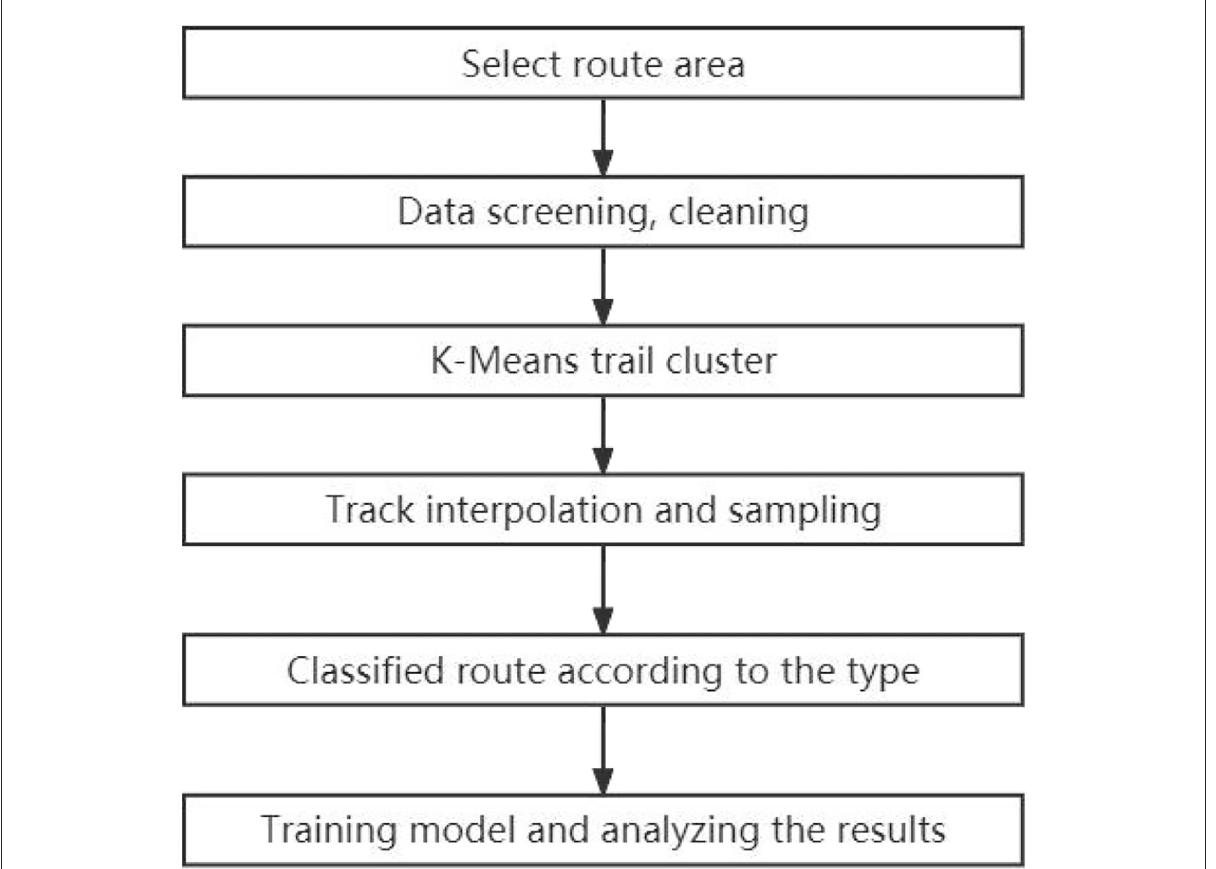
FIGURE3 Flowchart of the route generation